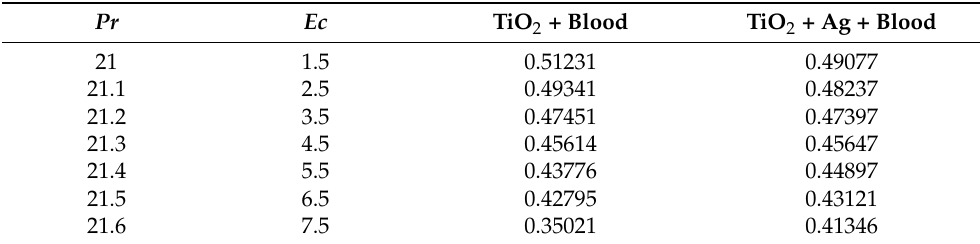
Table 2. Comparison of the Nusselt number ( Re λ = 0.7.